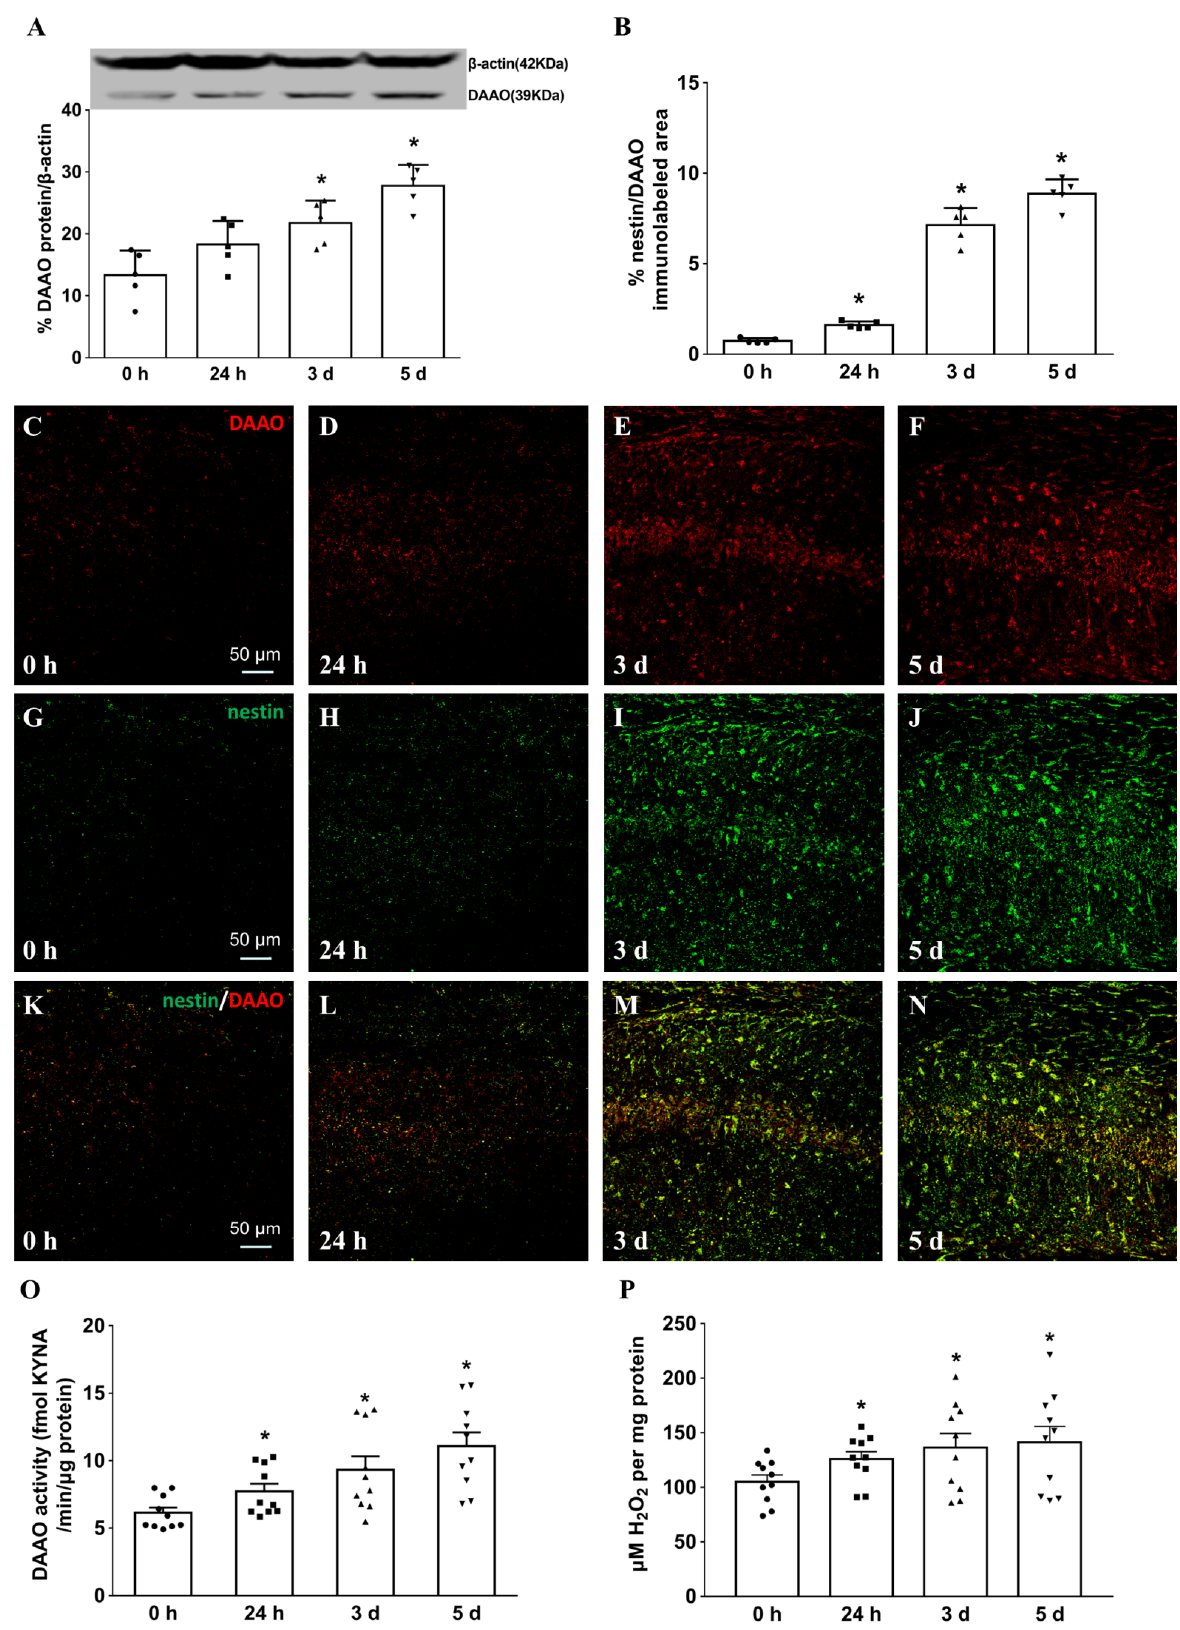
Figure 2. Time courses of hippocampal DAAO expression and related activity after acute ischemic insult. Western blot ( A ), colocalized nestin/DAAO immunostaining ( B – N ), and DAAO